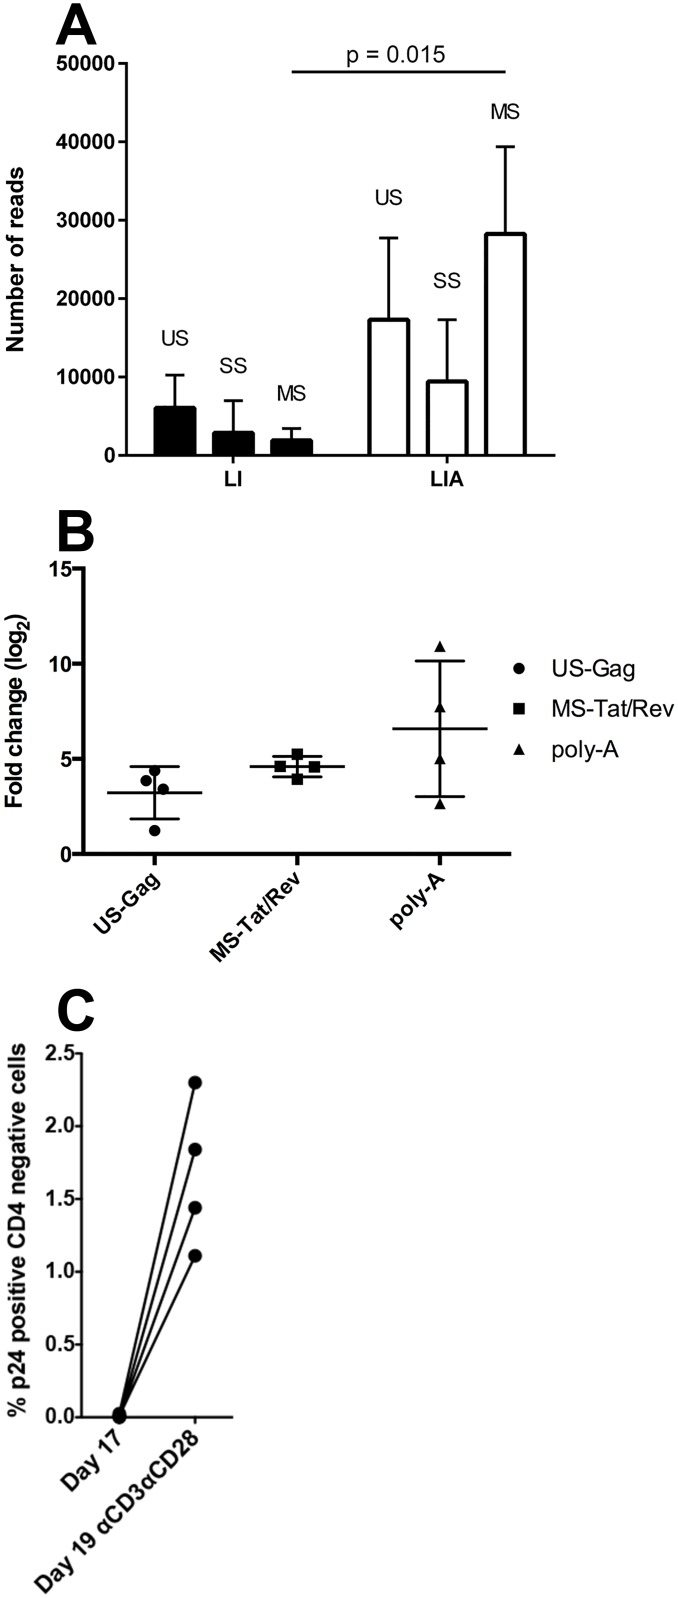
HIV-1 splicing variants are upregulated following αCD3/αCD28 stimulation.(A) The abundance of HIV-1 unspliced (US), singly spliced (SS), and multiply spliced (MS) transcripts in the LI and LIA conditions was estimated by mapping reads over the two major splice sites D1 and D4 (see Materials and Methods for details). No more than 4 reads were identified to map to the HIV-1 genome in samples from the uninfected conditions (UI and UIA), which may reflect expression from endogenous retroviral elements in the human genome. The significance of increases in each class of HIV reads upon activation was assessed using a one-tailed paired t-test but only an increase in MS reads was identified as significant (p = 0.015). (B) Fold changes upon activation of US RNA (US-Gag), MS RNA (MS-Tat/Rev) and polyadenylated RNA were determined by RT-qPCR. Significance of fold changes was confirmed using a one-tailed paired t-test and all RT-qPCR measurements were identified as significant at the p<0.001 level. Fold change is plotted on the log2 scale with error bars representing standard deviation. (C) Surface CD4 and intracellular HIV-1 p24 Gag expression were measured by flow cytometry as indicated in Materials and Methods after isolation and after reactivation with αCD3/αCD28 beads for 48 hours.